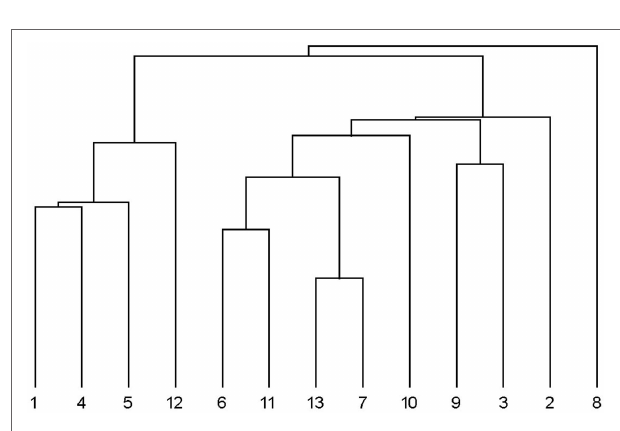
FigUre 6 | Dendrogram of the DAF dis-attenuated correlation